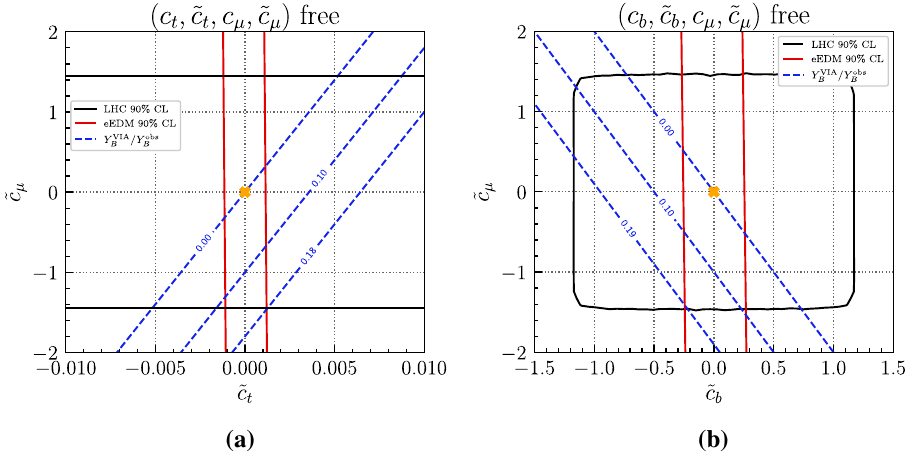
Fig. 12 2-flavor models ( t + μ, b + μ ): constraints on the CP -odd modifiers of a the top- and muon-, as well as b the bottom- and muon-Yukawa interactions. The legend corresponds to the one in Fig.